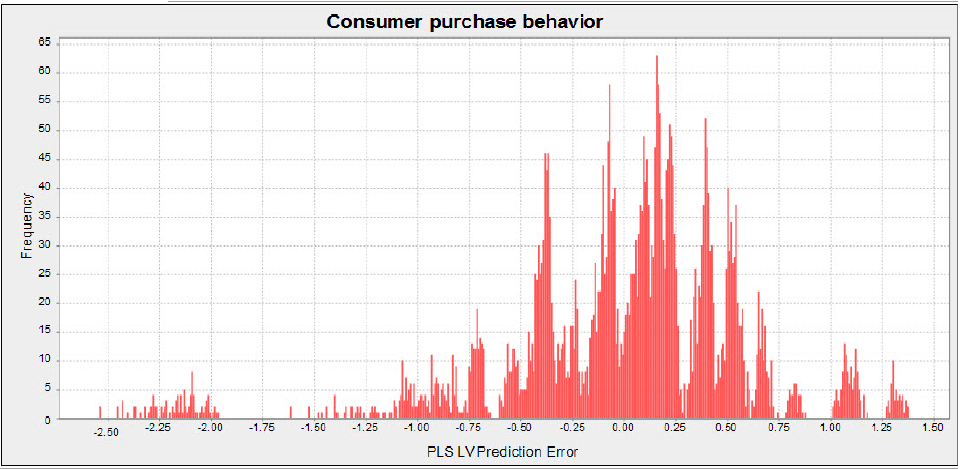
Figure 2. PLS LV prediction error of CPB.